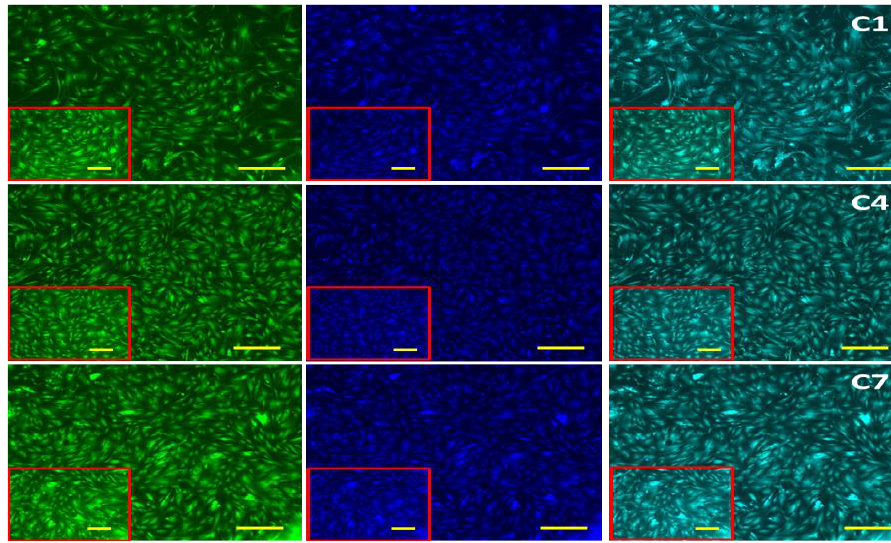
Figure 7. The effect of RPHX hydrogels on the proliferation of bone marrow mesenchymal stem cells cultured for 1, 4, and 7 days. Control cells treated without hydrogel, PVA solution 15 wt.%, RPH 0.1-0.1% retinol PVA, RPH 0.3-0.3% retinol PVA, RPH 0.5-0.5% retinol PVA. Asterisks repre- sent statistical significance, * p < 0.05 vs. Day 1, ** p < 0.001 vs. Day 1 of respective group.